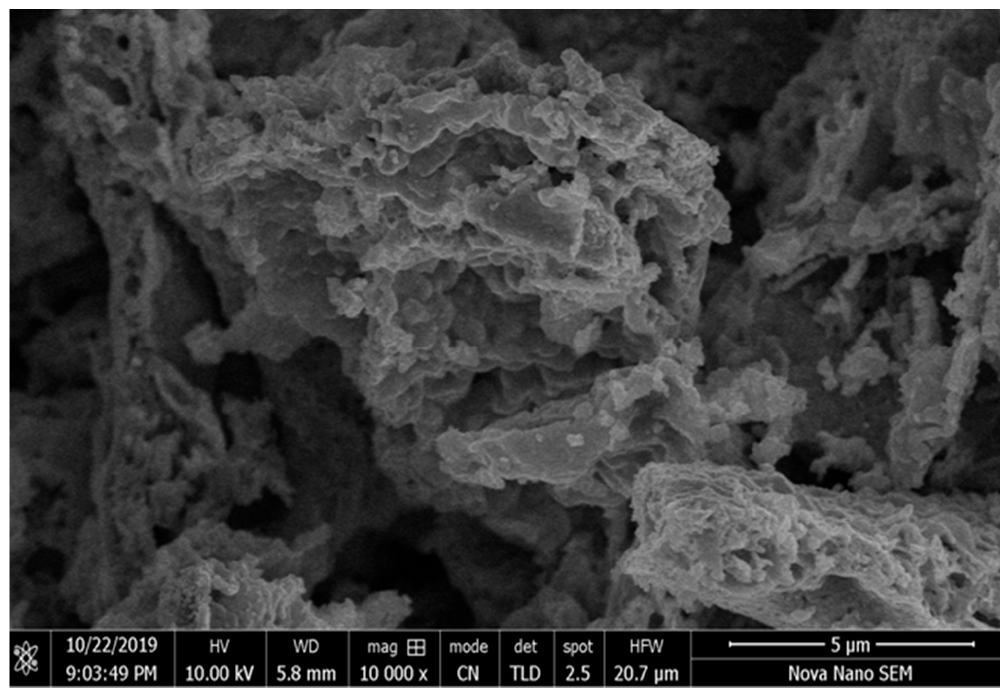
Figure 3. SEM image of undoped CoFe 2 O 4 at a resolution of 5 μ m.